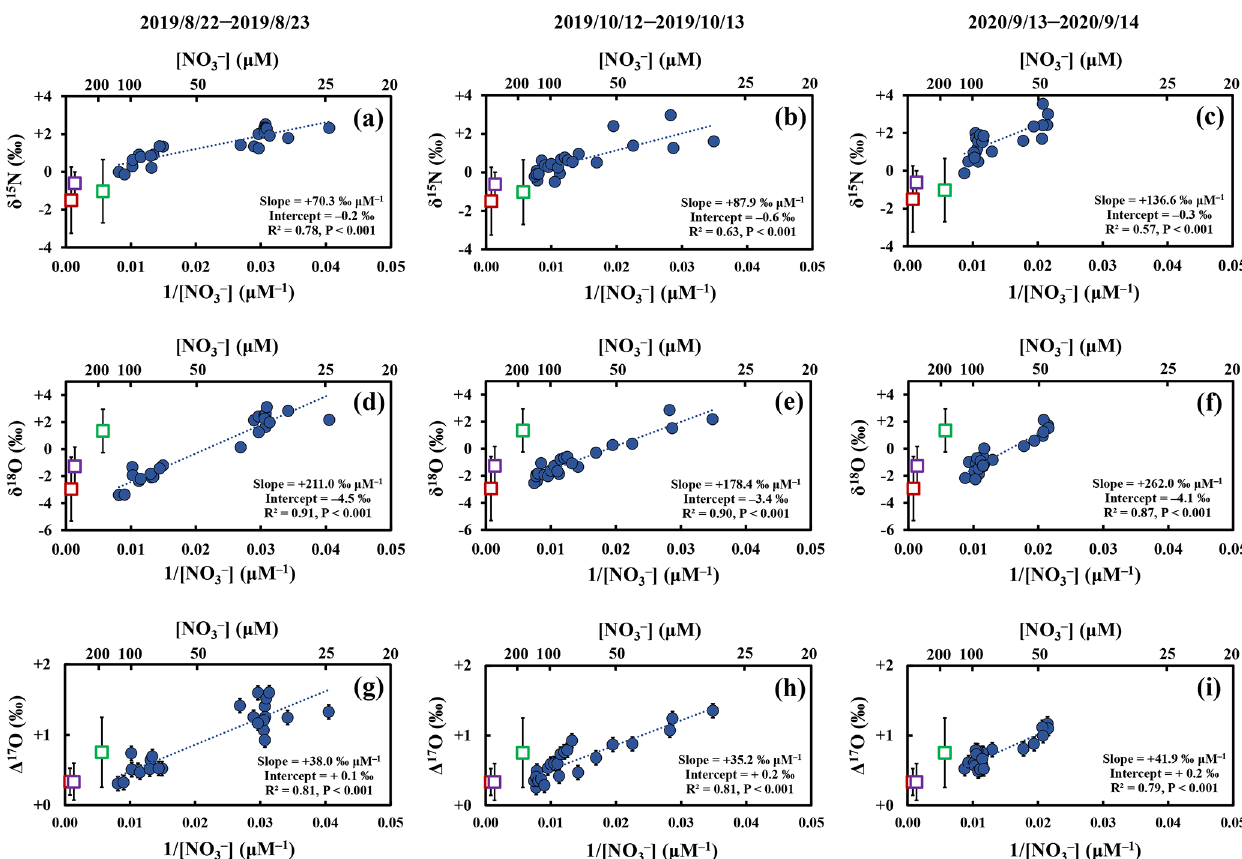
Figure 4. The δ 15 N (a–c) , δ 18 O (d–f) , and (cid:49) 17 O (g–i) values of stream nitrate (blue circles) during storm events I, II, and III plotted as ] ), together with those of soil nitrate at SLS 20 (red squares; riparian zone), a function of the reciprocal of nitrate concentration (1 / [ NO − 3 SLS 60 (purple squares; riparian zone), and SMS 20 (green squares; upland zone) during August to October in 2013 and 2014. The error bars of each soil nitrate denote the standard deviation (SD) of each isotopic composition ( n = 5 for each). The error bars smaller than the sizes of the symbols are not